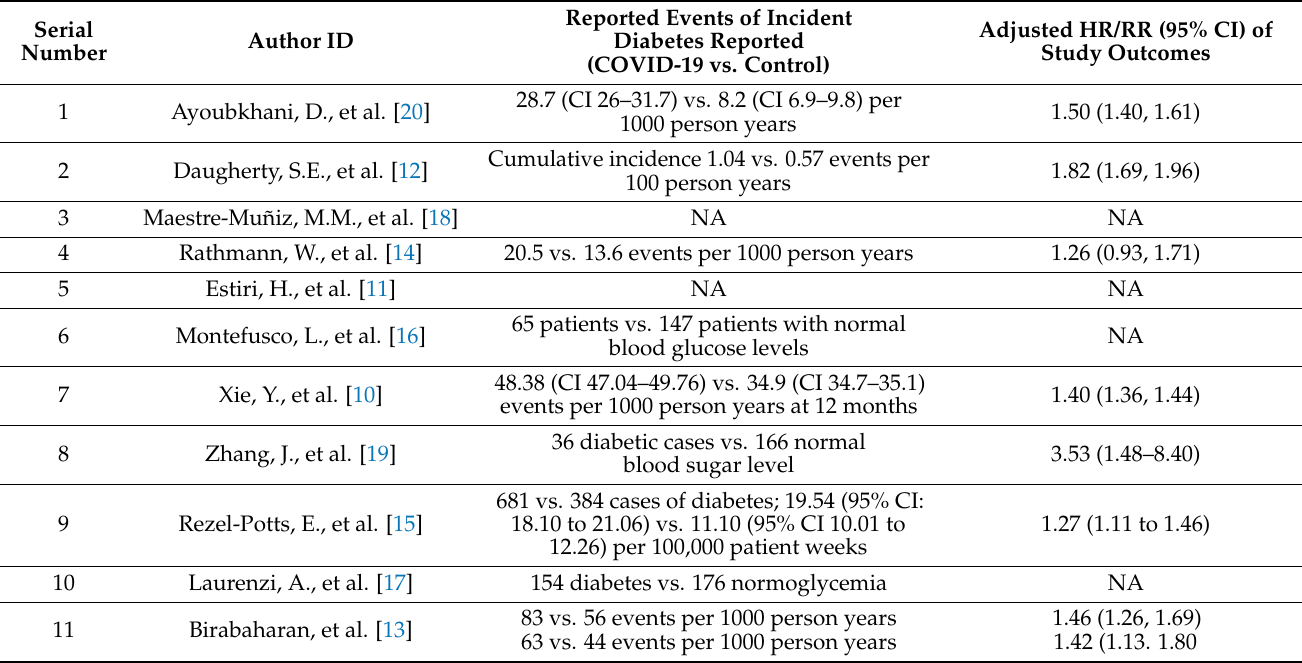
Table 3. Reported outcomes from included